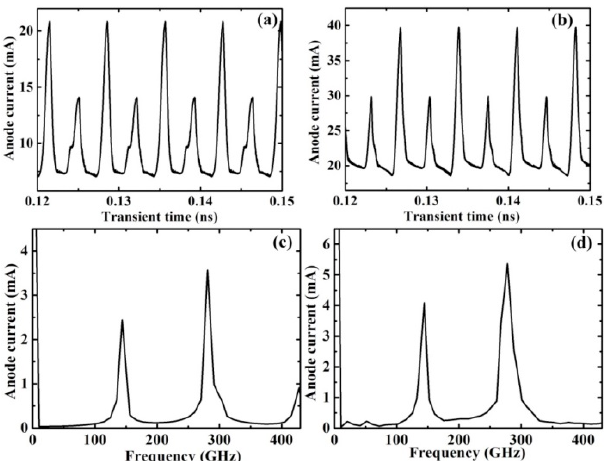
Figure 6. The RF performance for asymmetric SPD where L 2 = 1.2 µm = 2 L 1 : ( a ) and ( b ) are the oscillation current waves for the single-2DEG-channel SPD and triple-2DEG-channel SPD respectively; ( c ) and ( d ) are the spectrums for the single-2DEG-channel SPD and triple-2DEG-channel SPD respectively.